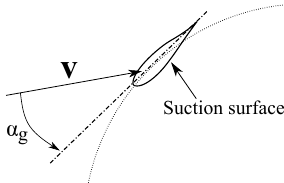
Figure 2. Positive angle of